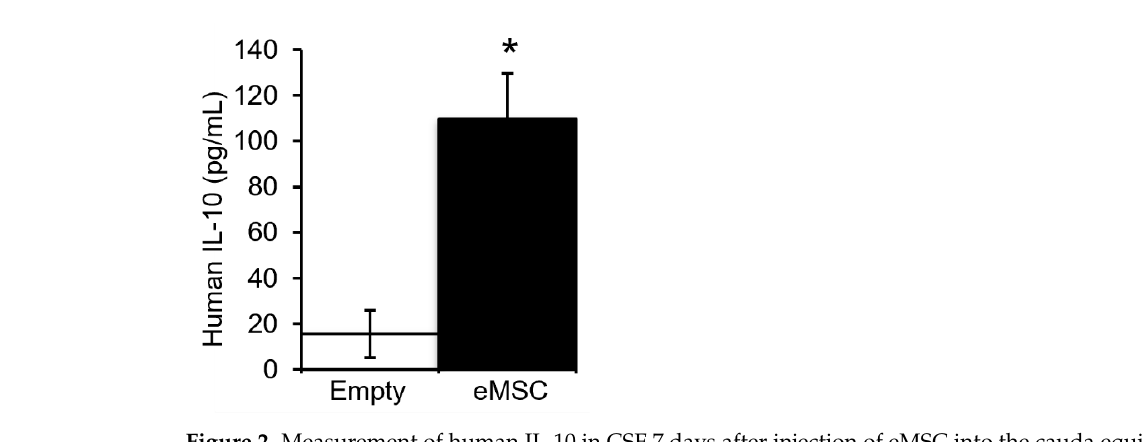
Figure 2. Measurement of human IL-10 in CSF 7 days after injection of eMSC into the cauda equina of SCI rats. Levels of human IL-10 were measured by ELISA in CSF collected from the foramen magnum at the base of the brain of SCI rats injected with capsules, without (empty) or with eMSC ( n = 2/group). Student t-test was used for statistical analysis. * p < 0.05.